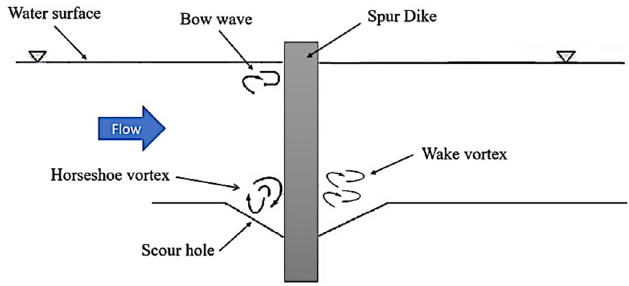
Figure 5. Development of vortex system around the spur dike (adapted from [36] ).